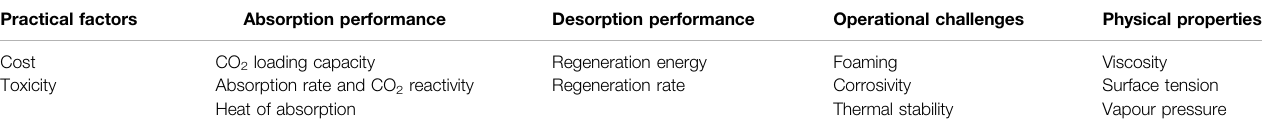
TABLE 4 | Selection criteria for liquid chemical absorbents. Practical